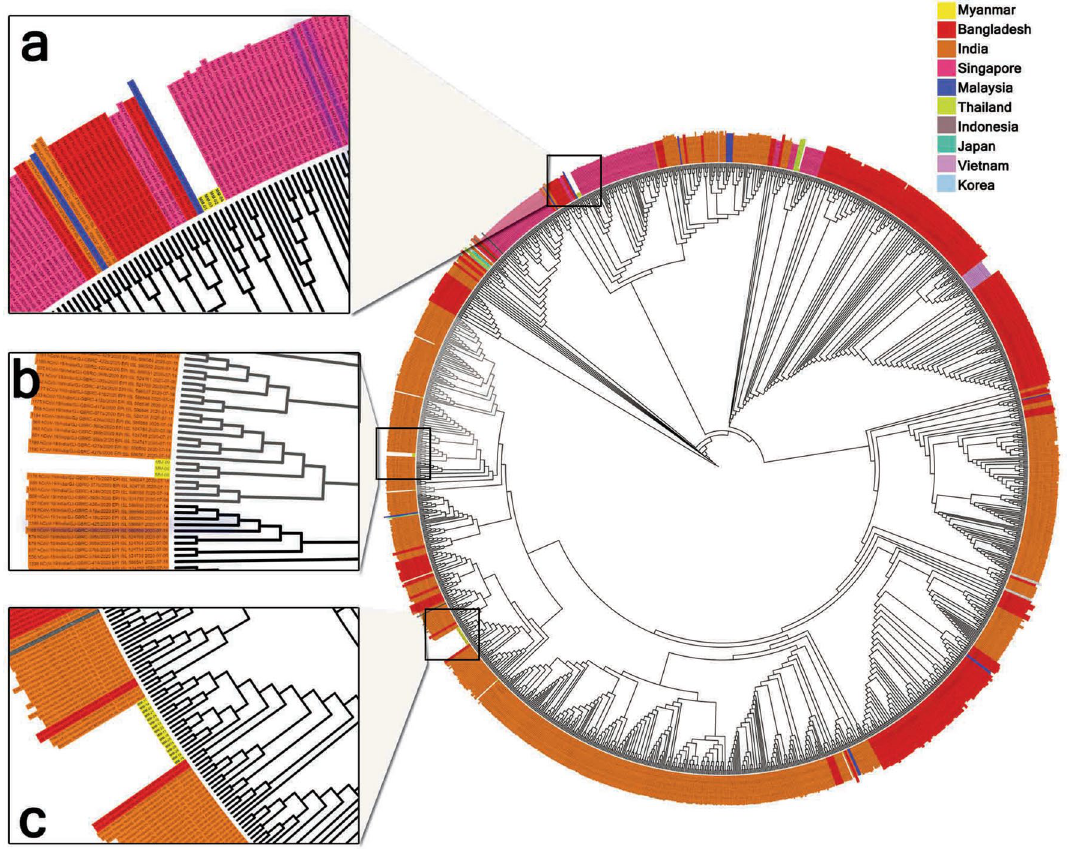
Figure 1. Maximum likelihood analysis clades of the 30 whole-genomes on SARS-CoV-2 in Myanmar, 2020 and sequences deposited at GISAID within July-1 to August-31, 2020 from India (820 sequences), Bangladesh (240 sequences), Thailand(5 sequences), Malaysia (13 sequences), Singapore(148 sequences), Indonesia (3 sequences), Japan (3 sequences), and Korea (3 sequences) with NC 045512.2 (Wuhan-Hu-1) as a reference. All sequences from local cases in Myanmar before the August-2020 were closely related to the Singapore clades ( a ). All sequences after August-2020 were appeared at the same clade with India and Bangladesh ( b , c